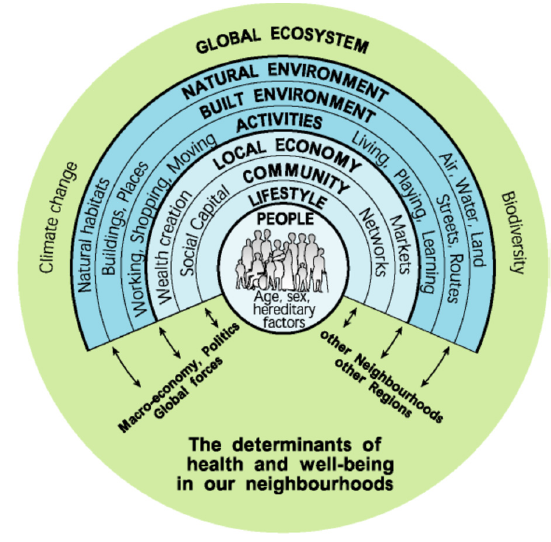
Figure 2. Determinants of health and wellbeing. Source: [60].